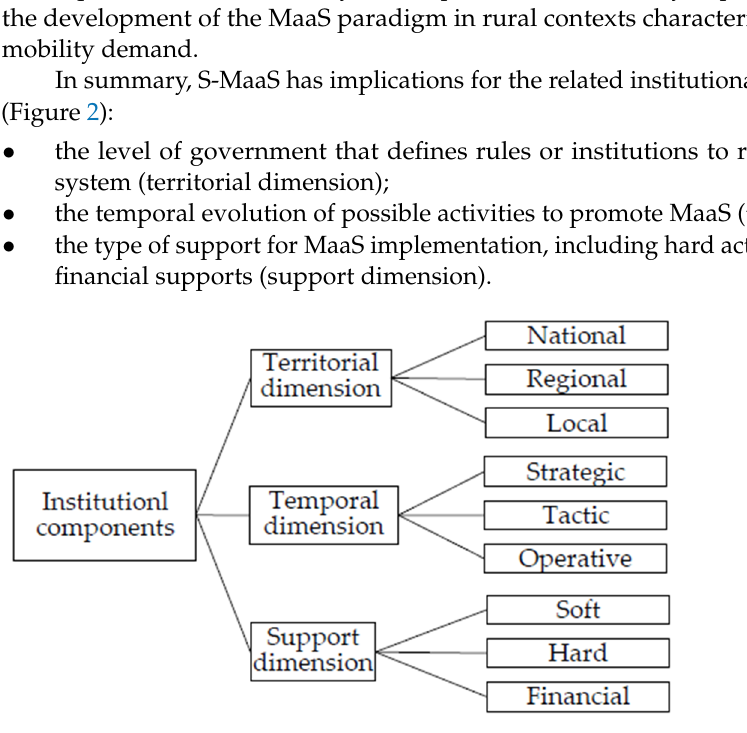
Figure 2. Governance: institutional components.